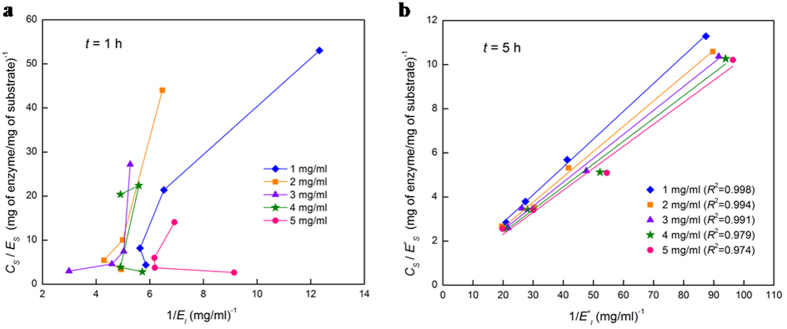
Nature of enzyme adsorption on the solid hemicellulose surface.(a) Non-equilibrium adsorption of enzyme at 1 h. (b) Equilibrium adsorption of the Langmuir-type at 5 h. Solid points are the (mean) experimental data (from runs in 0.1 M sodium acetate buffer solution of pH 5 at 4 °C, Cs = 1–5 mg/ml and E0/Cs = 0.1–0.4), and solid lines are the best-fits.